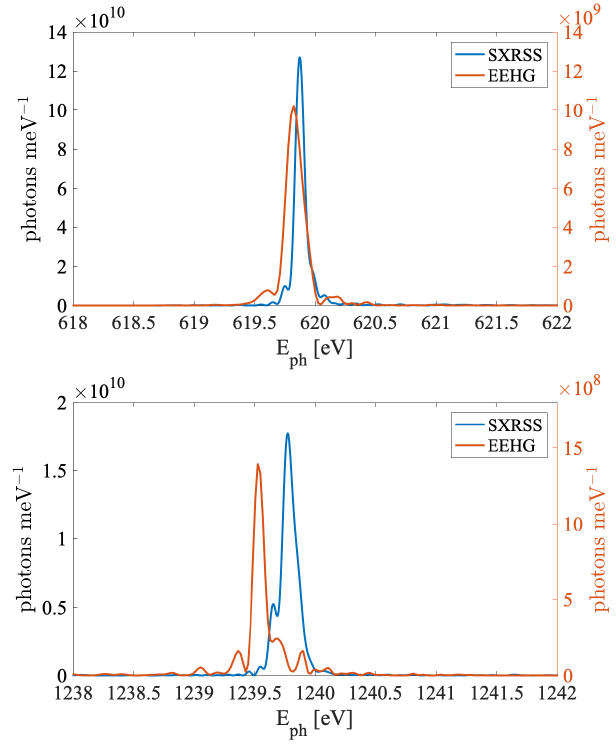
FIG. 4. X-ray spectra of SXRSS and EEHG near saturation for the ideal